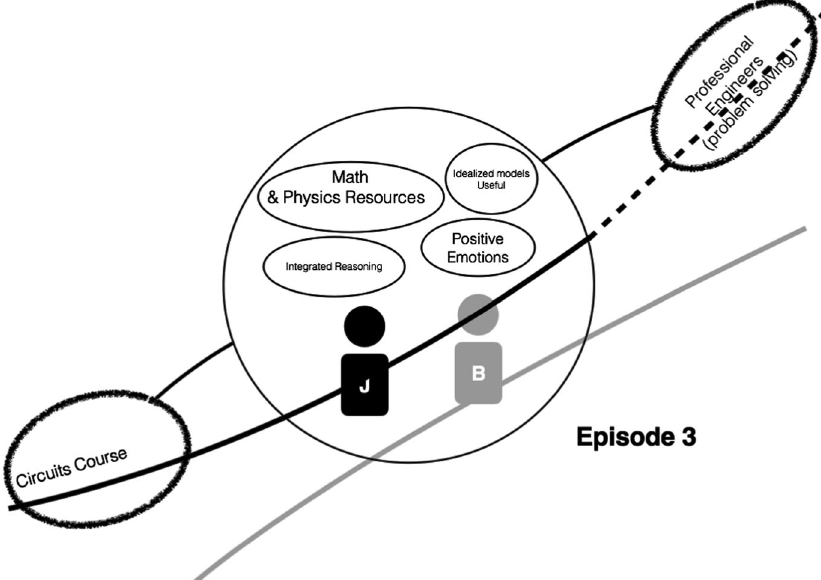
FIG. 8. Visual representation of the analysis of episode 3. Judy (marked as J) and Brian (marked as B) are shown as co-supporting the aspects of the interview conversation that we model labeled as “ Math and physics resources, ” “ Idealized models useful, ” “ Positive emotions, ” and “ Integrated reasoning. ” Judy ’ s trajectory through time (thick black line going through Judy) is shown as moving through past experiences in the Basic Circuits course, through the present time of the interview, into the projected future (represented by dotted black line) of participating in community of professional engineers. Math and physics resources here refers to the conceptual knowledge elements that Judy is drawing on in order to solve problems. Integrated reasoning refers to the epistemological behavior where idealized models and conceptual reasoning are integrated in her problem solving. Idealized models useful refers to the epistemological stance that idealized models are useful. That the elements modeling in the “ interview ” space have links to past course experiences and the projected future as a professional engineer is highlighted via thin connecting lines between the